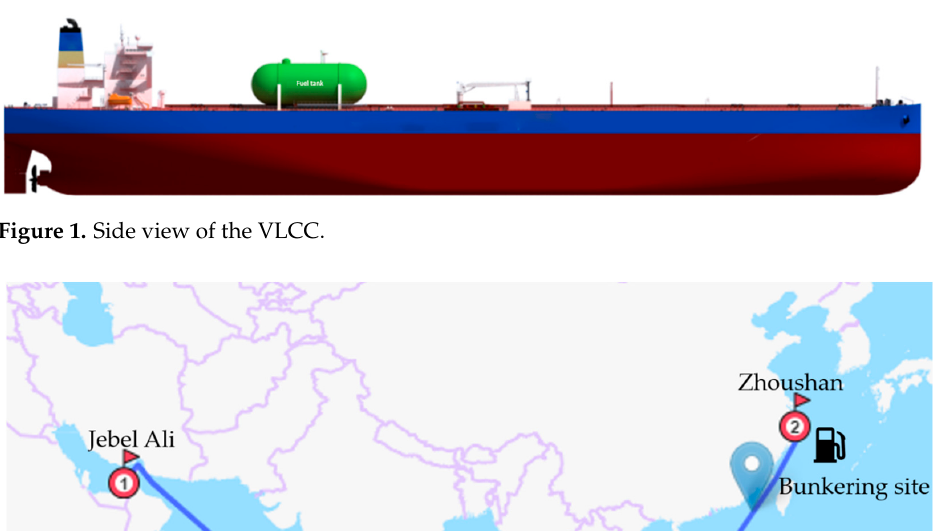
Table 1. Parameters of the VLCC.